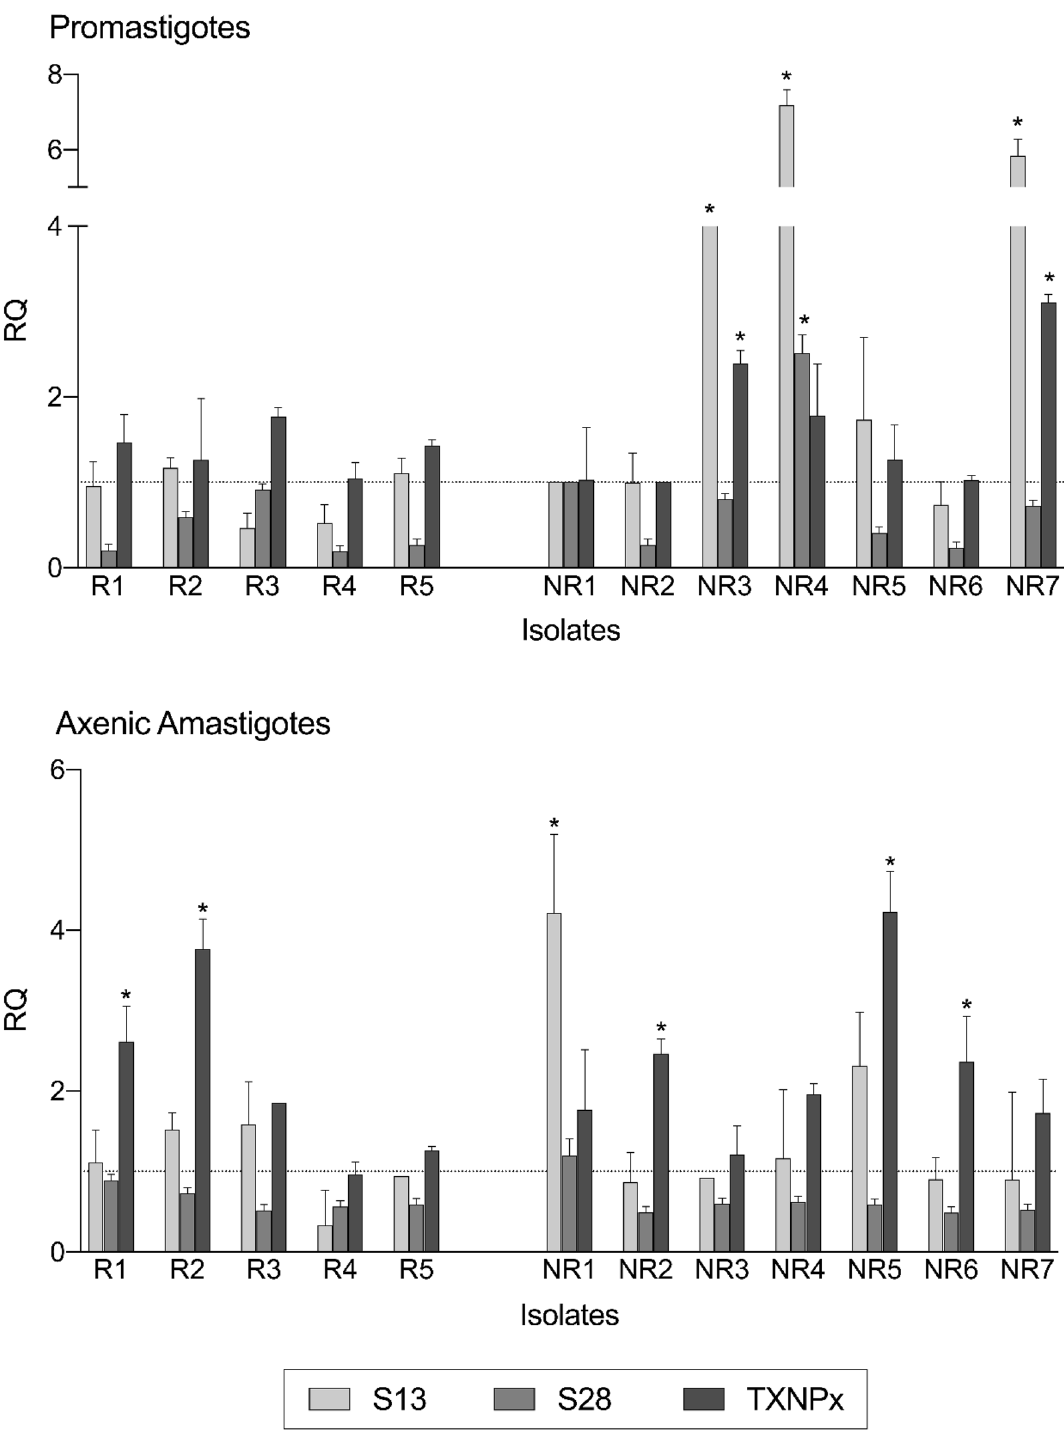
Figure 4. Differential gene expression of subtilisins and TXNPx of promastigotes and axenic amastigotes of L. ( V. ) braziliensis clinical isolates. Transcript levels were evaluated by qRT-PCR and the resulting relative quantification (fold-change) values of subtilisins (LbrM.13.0860, silver bars), (LbrM.28.2570, nickel bars) and TXNPx (LbrM.15.1080, iron bars) are presented. Actin and protein S8 were used as endogenous controls. The ∆∆Ct value of each gene was calculated pair-to-pair between promastigotes and axenic amastigotes, and the promastigote sample with lowest expression for each gene was set as reference sample. The dashed lines indicate RQ level 1 of the reference samples: NR1 promastigote for subtilisins; NR2 promastigote for TXNPx. The graph presents the mean of two independent experiments performed in triplicate. * p < 0.05. The figure was generated using GraphPad Prism version